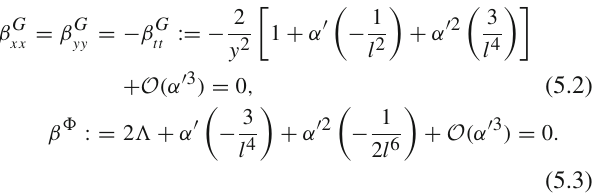
Coordinate transformation Original